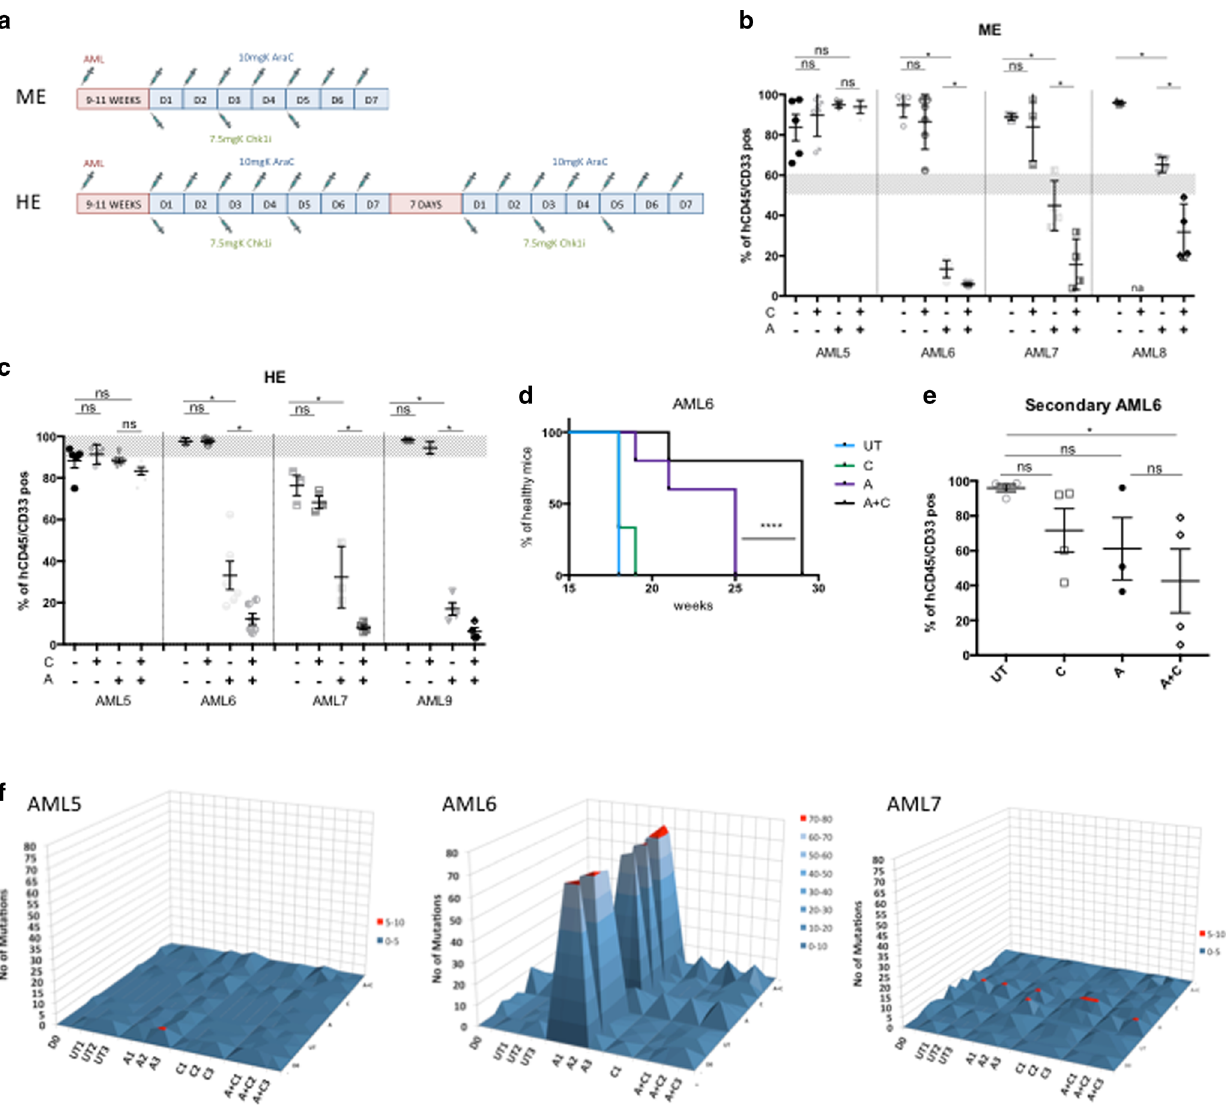
Fig. 3 CHK1i enhances the cytotoxicity of AraC in different primary AML models in vivo and reduces mutagenic potential. a Scheme of treatment regimen for AML patient samples starting with medium engraftment (ME) and high engraftment (HE). b Percentage of human cells in the bone marrow of mice transplanted with four primary AML patient samples. The treatment started at ME (gray area) and the analysis was performed on BMs of killed mice 1 week post treatment. Each dot represents an individual mouse. (AML5 UT n = 5; C n = 5; A n = 5; A+C n = 6; AML6 UT n = 5; C n = 6; A n = 5; A+C n = 5; AML7 UT n = 3; C n = 3; A n = 4; A+C n = 4; AML8 UT n = 3; C n = 0; A n = 4; A+C n = 4; total number of mice = 67). c Same as in b but the treatment started at HE (gray area). (AML5 UT n = 5; C n = 3; A n = 5; A+C n = 6; AML6 UT n = 3; C n = 3; A n = 6; A+C n = 6; AML7 UT n = 3; C n = 3; A n = 3; A+C n = 4; AML9 UT n = 3; C n = 5; A n = 5; A+C n = 4; total number of mice = 67). d Sickness curves monitoring AML6-injected mouse under different treatment conditions at various time points. Mice were euthanized when a 20% reduction of body weight was reached (UT n = 3; C n = 3; A n = 4; A+C n = 4). We used the Gahan – Breslow – Wilcoxon for statistical analysis. e Secondary transplantation of hCD45/CD33 + cells, pooled from AML6-injected mice 1 week post treatment. Each dot represents an individual mouse (UT n = 4; C n = 4; A n = 3; A+C n = 4). f 3D plots showing the changes in the mutation spectrum for each patient. Mutations present at D0 sample were compared to UT, A, C and A+C mice. * p < 0.05; **** p < 0.00005 and ns: non-signi fi